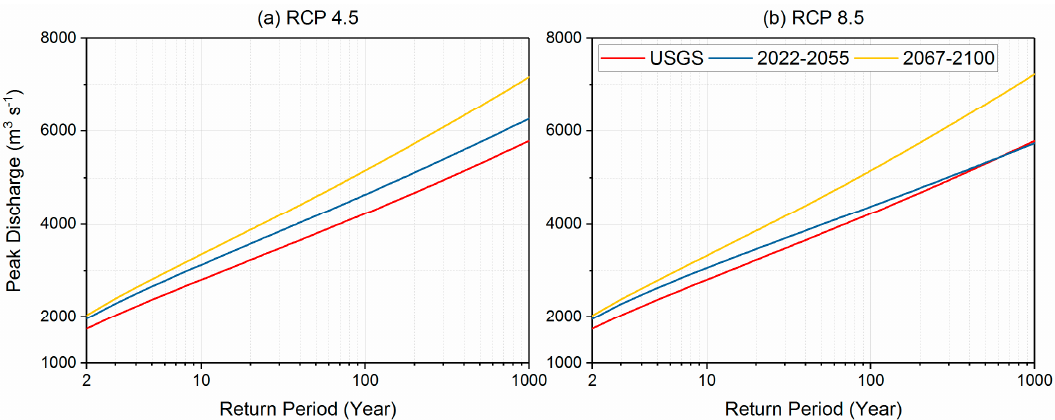
Figure 7. The frequency curves of the annual peak flow at Monroe for USGS instantaneous observations (1964–2014), RCP4.5 ( a ); and RCP8.5 ( b ) made by the Bulletin 17C method. (1964–2014), RCP4.5 ( a ); and RCP8.5 ( b ) made by the Bulletin 17C